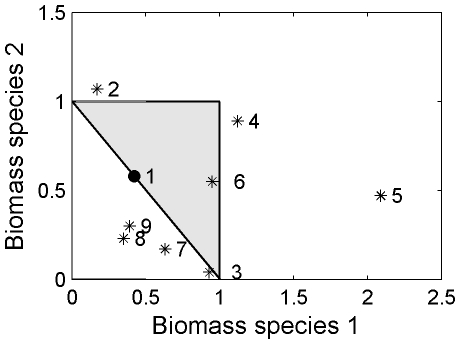
State-space for the steady-state population-level biomass from seven additional studies in the literature, in comparison with the results of this study.Three studies showed suppressed levels of function (#s 3, 7, and 8), one study showed elevated function consistent with classic resource-partitioning arguments (#6), and three studies showed increases in function for one species relative to its alone state, suggestive of a mutualism or other type of positive interaction (#s 2, 4, and 5). The studies were, with species 1 (on x-axis) listed first 1) Colpidium striatum versus Paramecium aurelia (this study, marked with solid circle), 2) Blepharisma americana versus Paramecium tetraurelia
[38], 3) Colpidium striatum versus Tetrahymena thermophyla
[38], 4) Chilomonas paramecium and Colpidium striatum (low nutrient levels; [37], 5) Chilomonas paramecium and Colpidium striatum (high nutrient levels; [37], 6) Colpidium striatum versus Paramecium tetraurelia (22°C; [22], 7) Colpidium striatum versus Paramecium tetraurelia (30°C; [22], and 8) Paramecium aurelia versus Paramecium caudatum
[24].